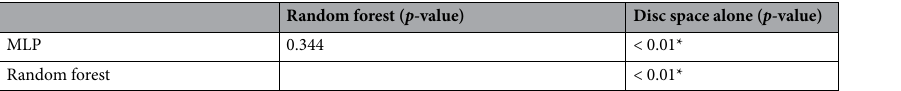
Table 3. Statistical significance of the difference between the areas under ROC curves. DeLong’s test and Bootstrap test were used. MLP multilayer